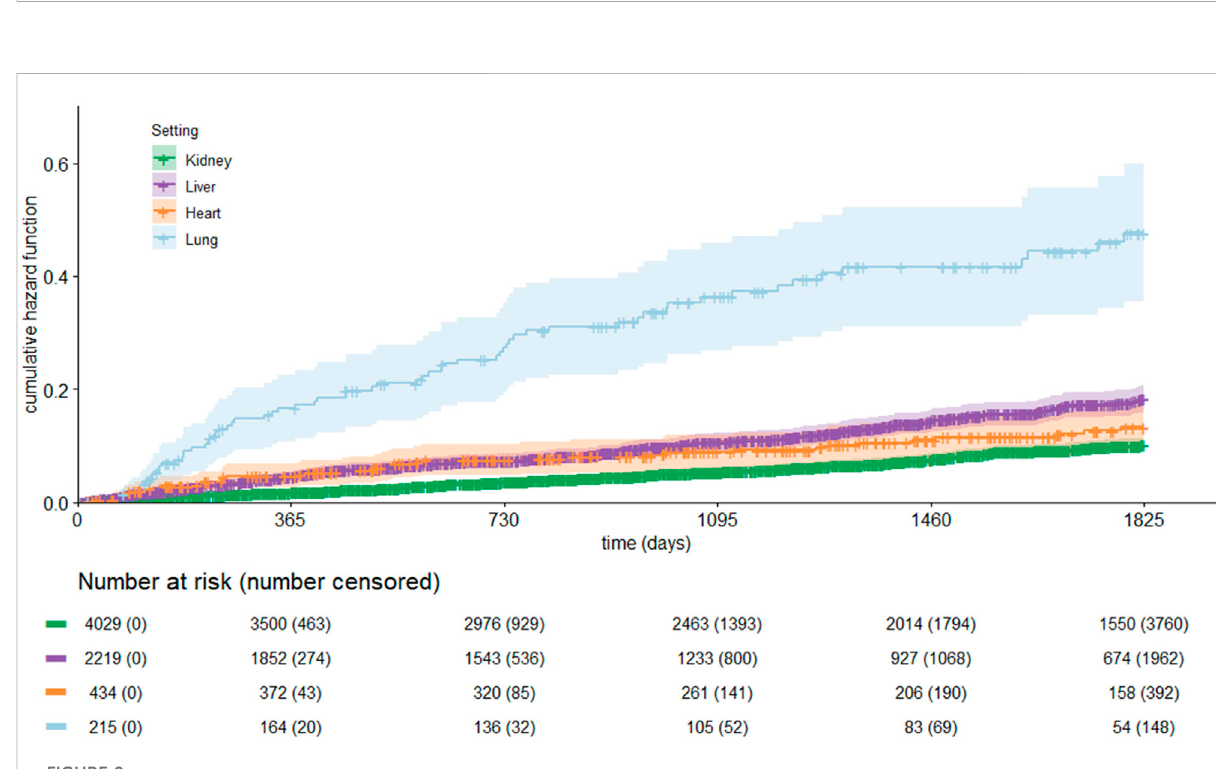
FIGURE 9 Kaplan-Meier curve for all-cause mortality by type of organ